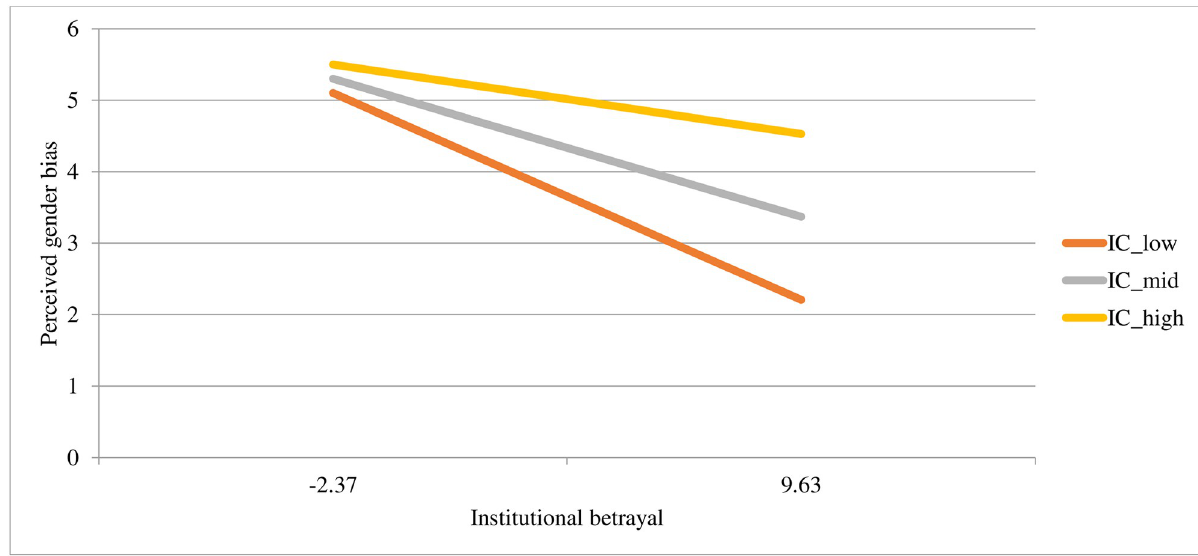
Fig 3. Associations between different levels of institutional courage (at -1SD, the mean, and +1SD) with gender bias at different levels of institutional betrayal (at -1SD and +1SD).